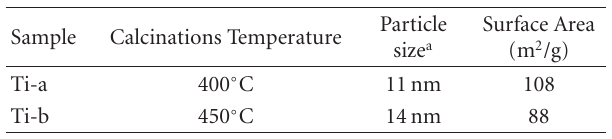
Table 1: Properties of Nanoporous TiO 2 .